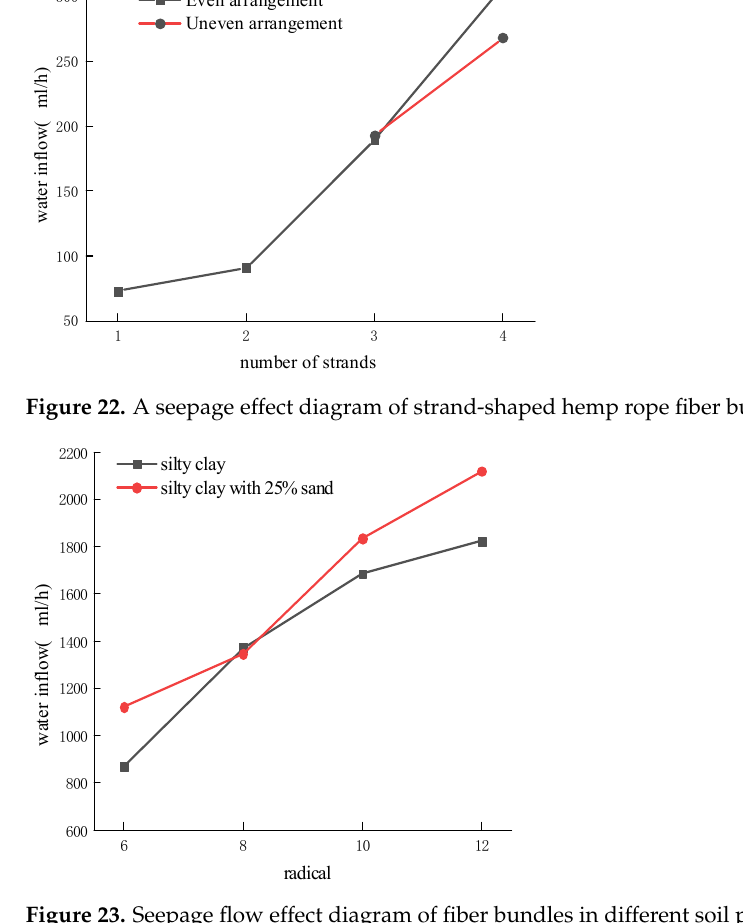
Figure 23. Seepage flow effect diagram of fiber bundles in different soil properties.